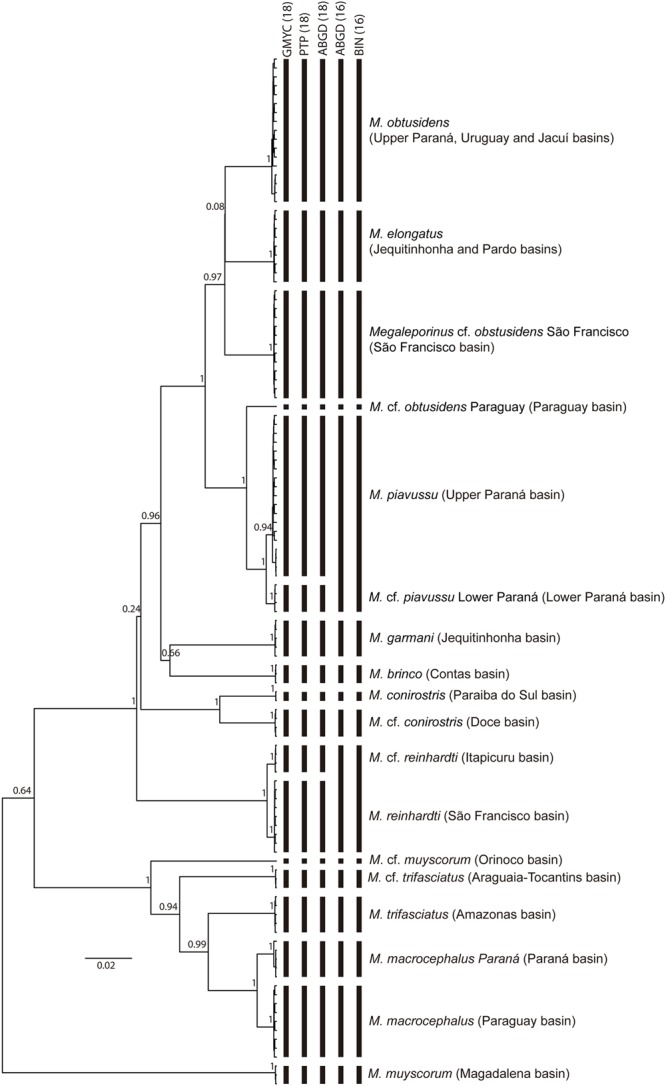
Bayesian tree showing the clustering of the MOTUs obtained by the species delimitation analyses.